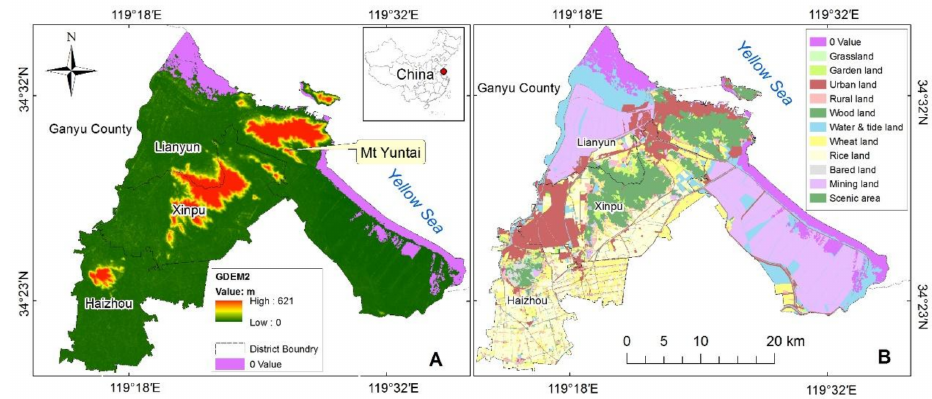
Figure 1. Study area consisting of Xinpu, Haizhou and Lianyun districts of Lianyungang: ( A ) GDEM2 at 30 m resolution; ( B ) land-use map for 2005, provided by Land and Resources Bureau of Lianyungang. Dark purple indicates the coastal areas with 0 value in